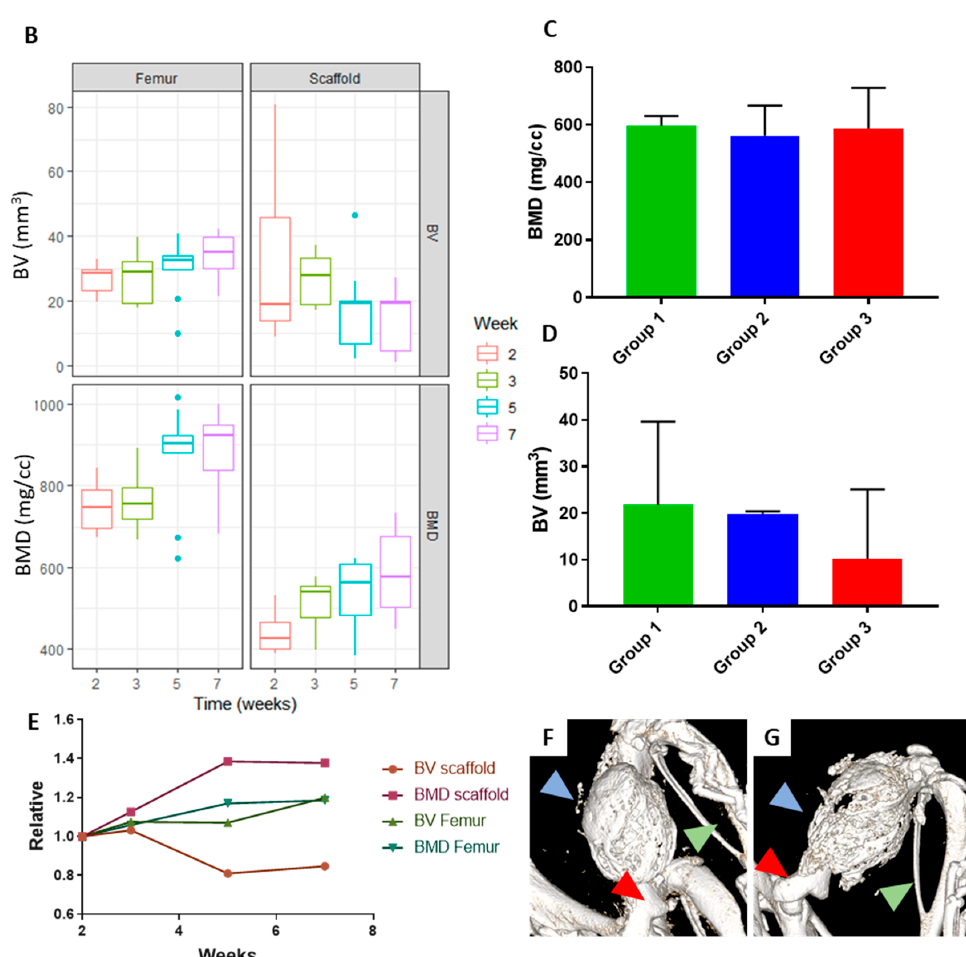
Figure 5. CD34 + cell implantation does not a ff ect the bone formation rates in vivo. ( A ) Analysis of the bone formation over a period of 8 weeks from in vivo µ CT (bone volume (BV) and bone mineral density (BMD)) depicting a transversal plane of a representative mouse. Blue arrows indicate the mouse femur and white arrows indicate the newly formed bone. ( B ) The bone volume (BV) of the sca ff old reached a peak on week 2 and stabilised after week 4, indicating the formation of an organised cortical shell. After this time, the BV did not significantly change. On the other hand, the bone mineral density (BMD) of the sca ff old increases with time, corroborating the organisation and growth of the bone organ. The BMD of the sca ff old increased over time. The BV and BMD of the mouse femur were stable and tended to increase slightly, as per normal body growth. Lines in boxplot indicate the median, top and bottom lines corresponding to the 25% and 75% percentiles. The dots indicate outliers. ( C ) Average values from the 3 di ff erent groups at week 7: control (group 1), unmatched (group 2) and matched (group 3), showing no statistical di ff erence in the sca ff old BMD ( C ) or the BV ( D ). ( E ) Representative example of an individual mouse, showing the stabilisation of the sca ff old’s BV after week 4, and the slight increase of the femur’s and sca ff old’s BMD overtime. In vivo CT images of the mouse femur and the ohTEBC at weeks 2 ( F ) and 5 ( G ). Blue arrowhead shows the construct, red points at the femur head and green shows the tibia and fibula of the